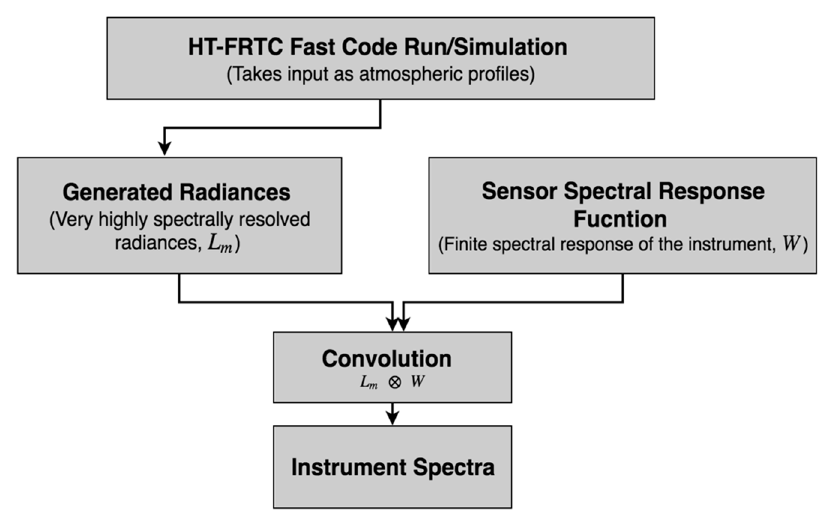
Figure 5. Flow diagram showing the process of reconstruction of instrument simulated spectra by the convolution of very high spectrally-resolved radiances with instrument spectral response function.